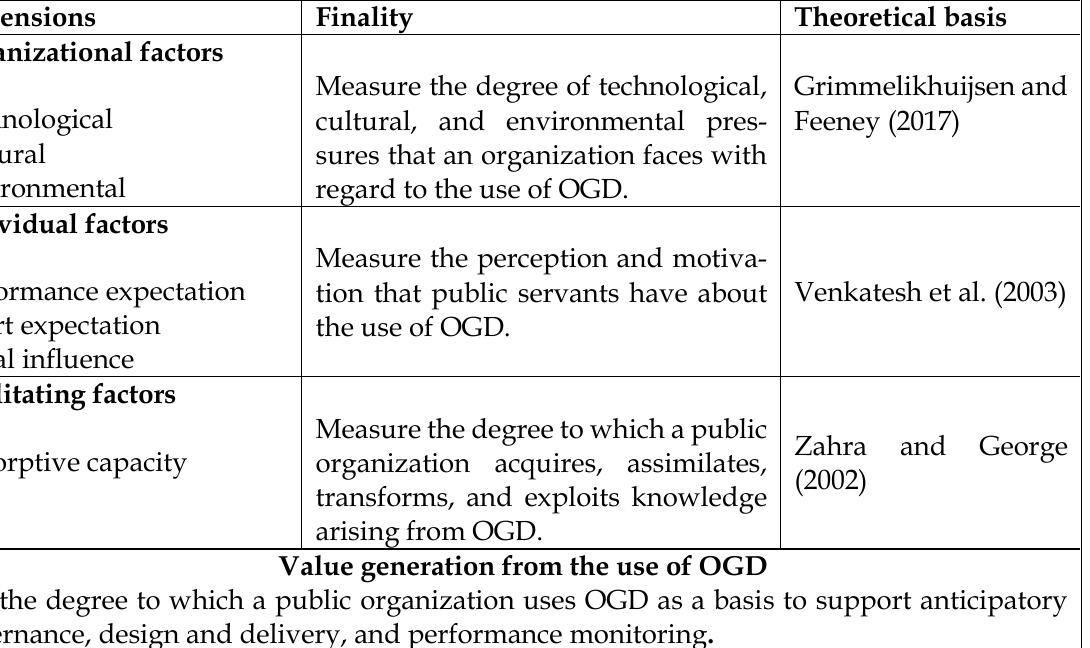
Table 1. Multidimensional scale